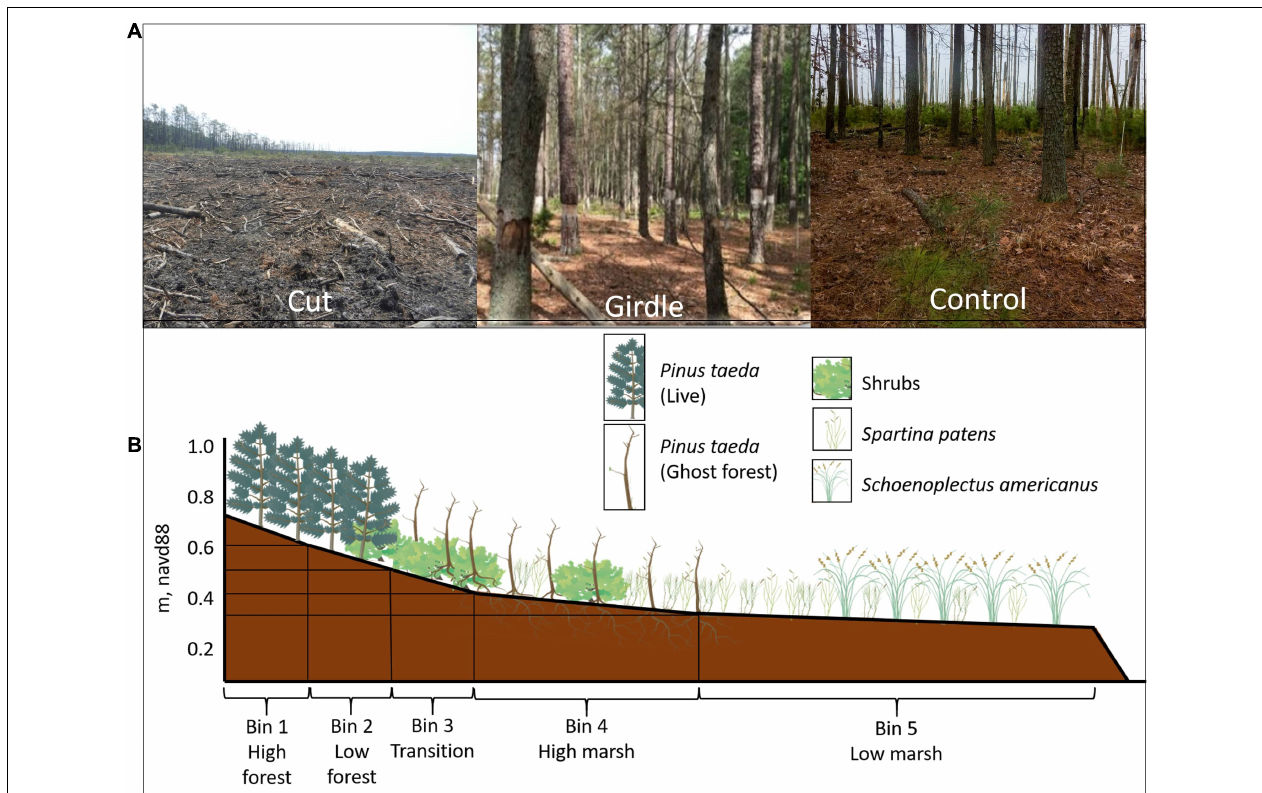
FIGURE 2 | (A) Pictures taken from Moneystump Swamp transgression experiment (Cambridge, MD, United States) in the highest elevation bin in the Cut treatment area immediately after the trees were cut down in 2014, the Girdled treatment area immediately after the bark was stripped from the trees to slowly kill them in 2014, and the Control area where the trees were left alive (Photo credit: Patrick Brennand). (B) Schematic showing typical vegetation zonation at Moneystump along elevation gradient spanning from the low marsh into the high forest, and how those ecotones align with the elevation bins chosen for the transgression